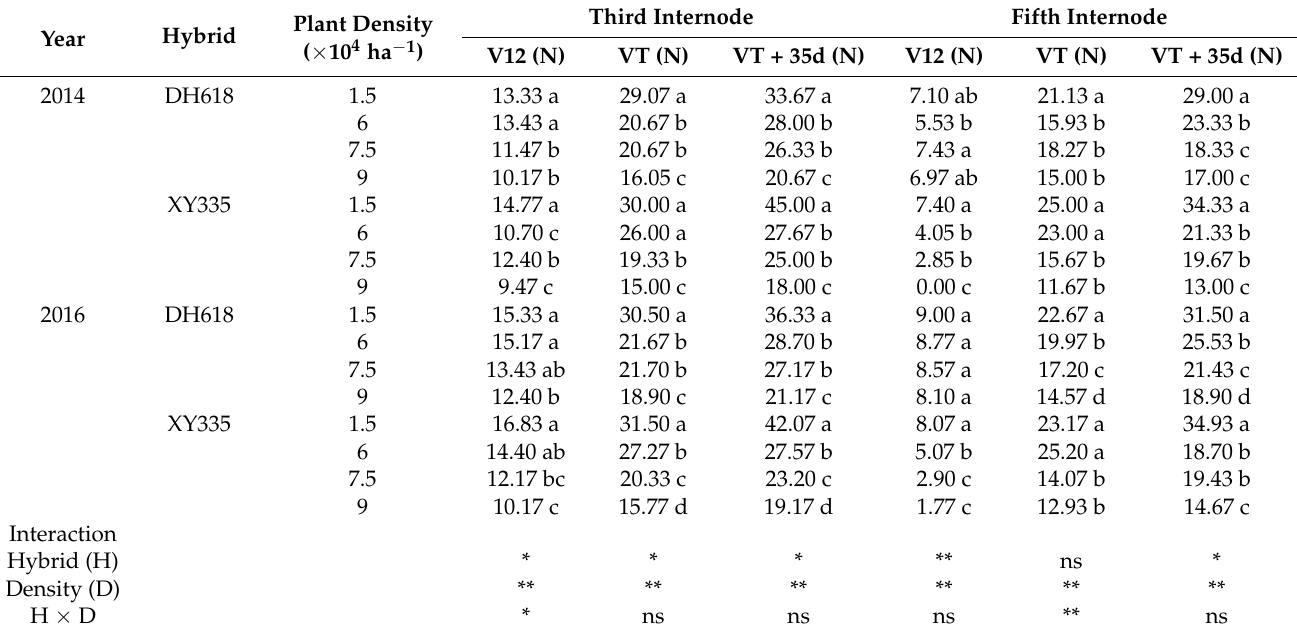
Table 2. Rind penetration strength of DH618 and XY335 at different growth stages in 2014 and 2016.